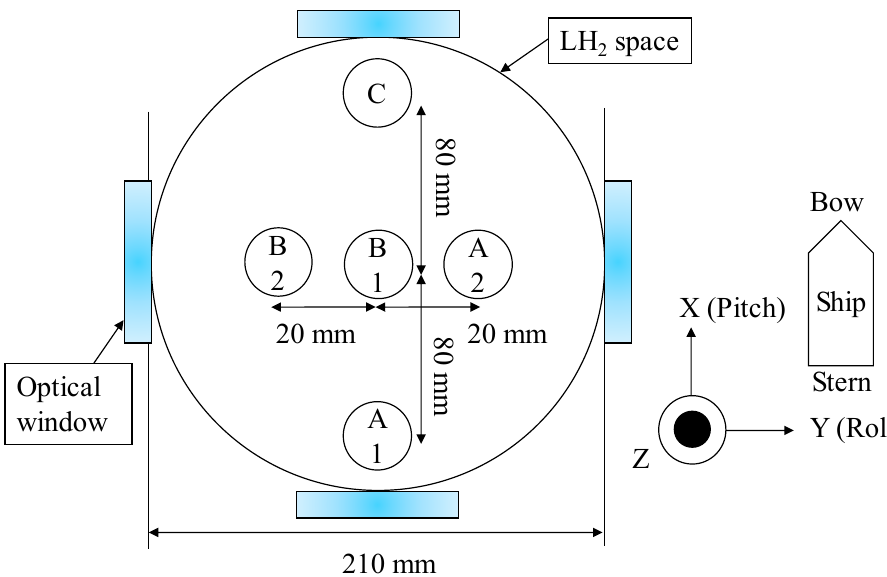
Figure 3. Layout of the five MgB 2 level sensors with a diameter of 0.32 mm.